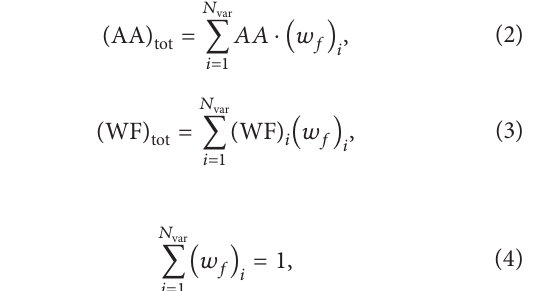
each contribution is dependent on the experimental accuracy, the relevance of the addressed parameter, and a component of normalization with reference to the average amplitude evaluated for the primary side